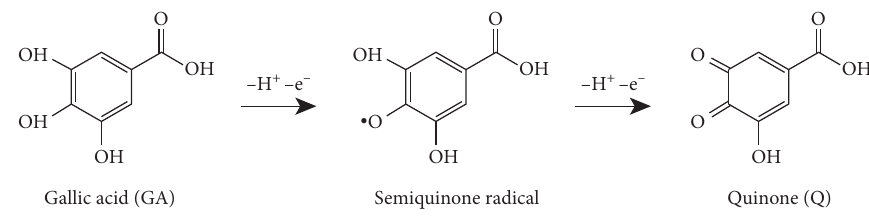
Scheme 2: Electrochemical oxidation of gallic acid